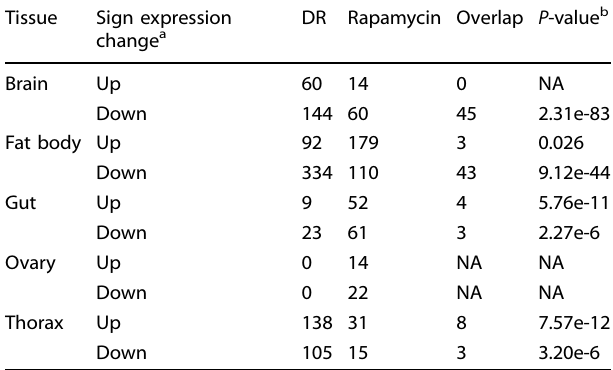
Table 2. Overlaps within tissues between DR and rapamycin- regulated DE genes Tissue Sign expression change a